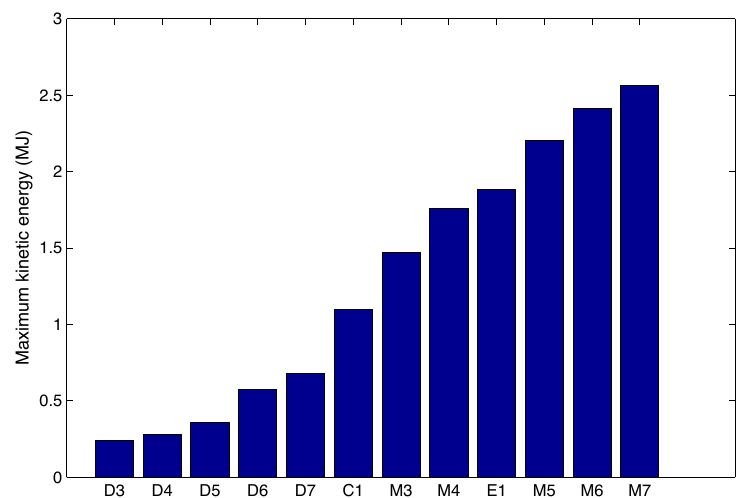
Figure 12. Maximum kinetic energy for all cases.